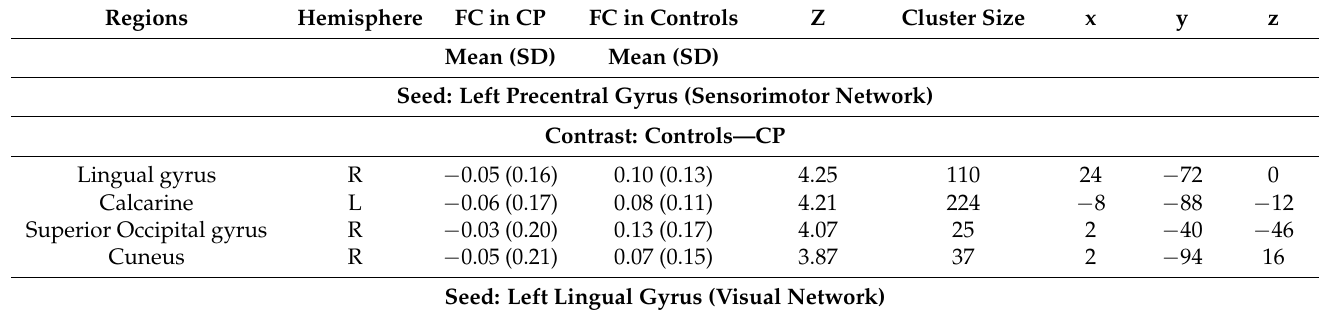
Table 2. Whole-brain functional connectivity differences between the neurotypical controls and youth with cerebral palsy. Regions Hemisphere FC in CP FC in Controls